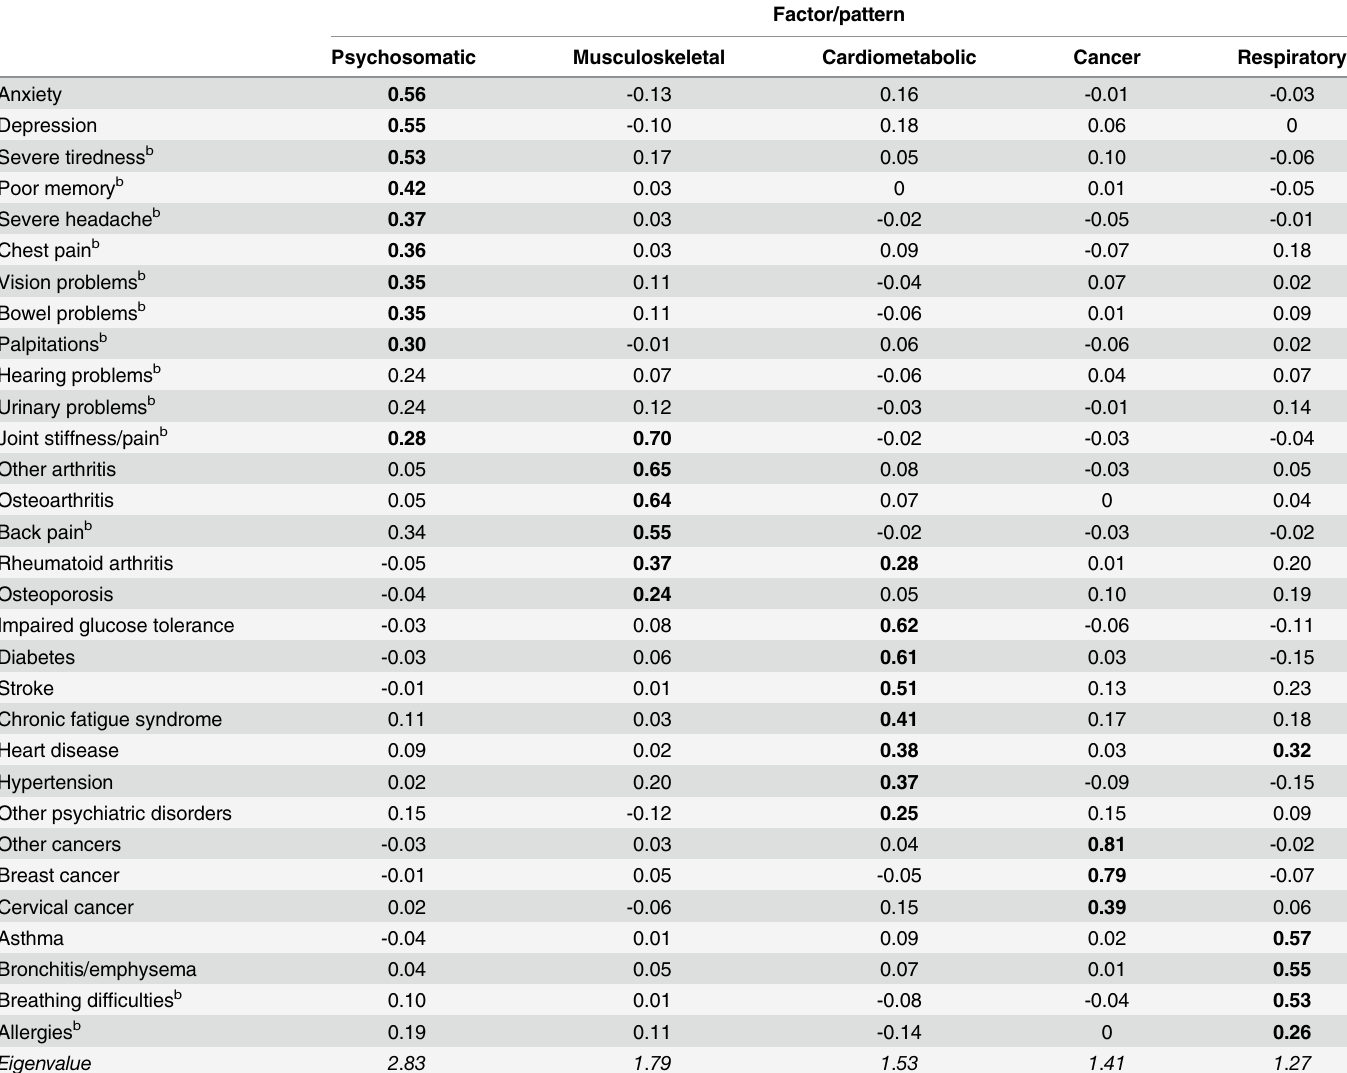
Table 2. Factor loadings a for chronic diseases and symptoms at survey 6.